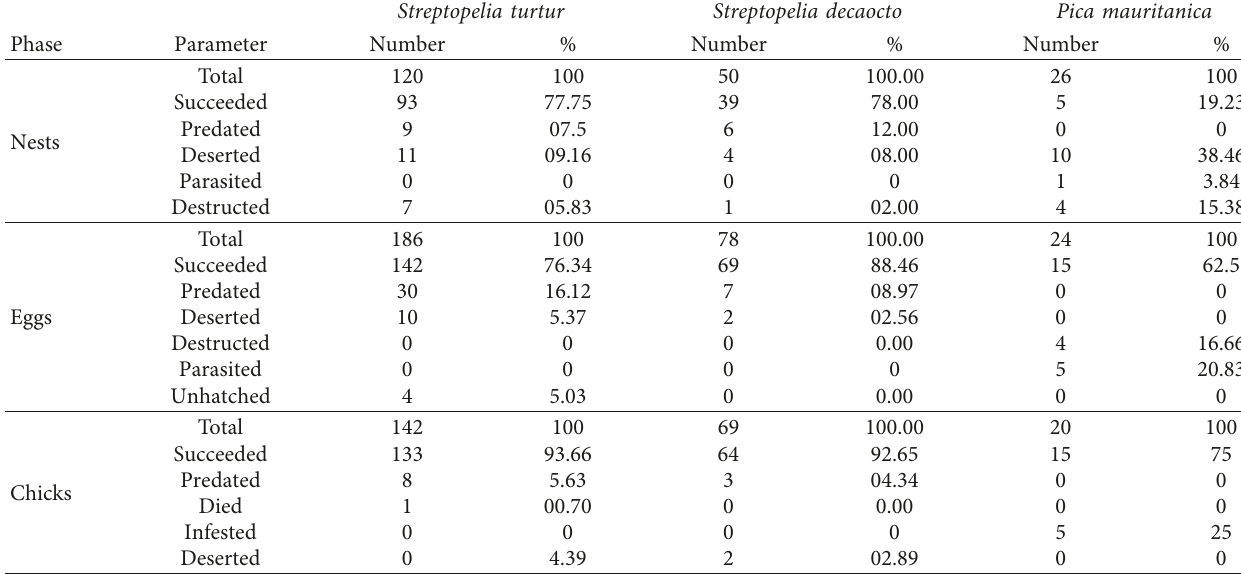
Table 2: Comparison of breeding success and failure factors among turtle dove ( n � 120 nests), collared dove ( n � 50 nests), and magpie ( n � 26 nests) in olive orchards at